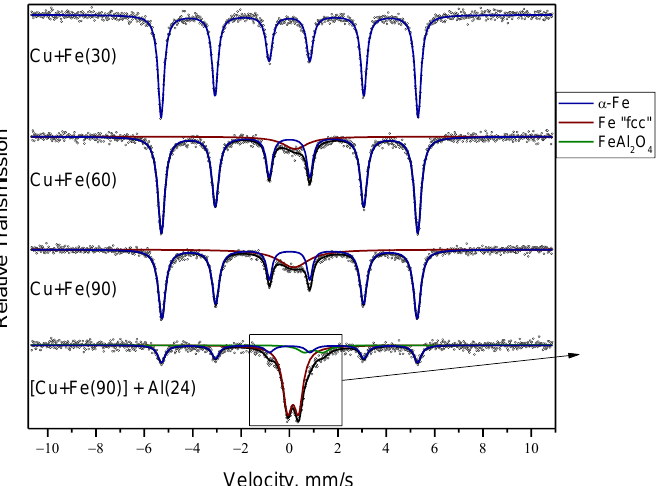
Figure 3. Mössbauer spectra of the products of MA Cu+Fe and (Cu+Fe) + Al. In the inset, an enlarged view of a part of the spectrum is presented. Table 2. Hyperfine parameters of the Mössbauer spectra were recorded from the powders *.